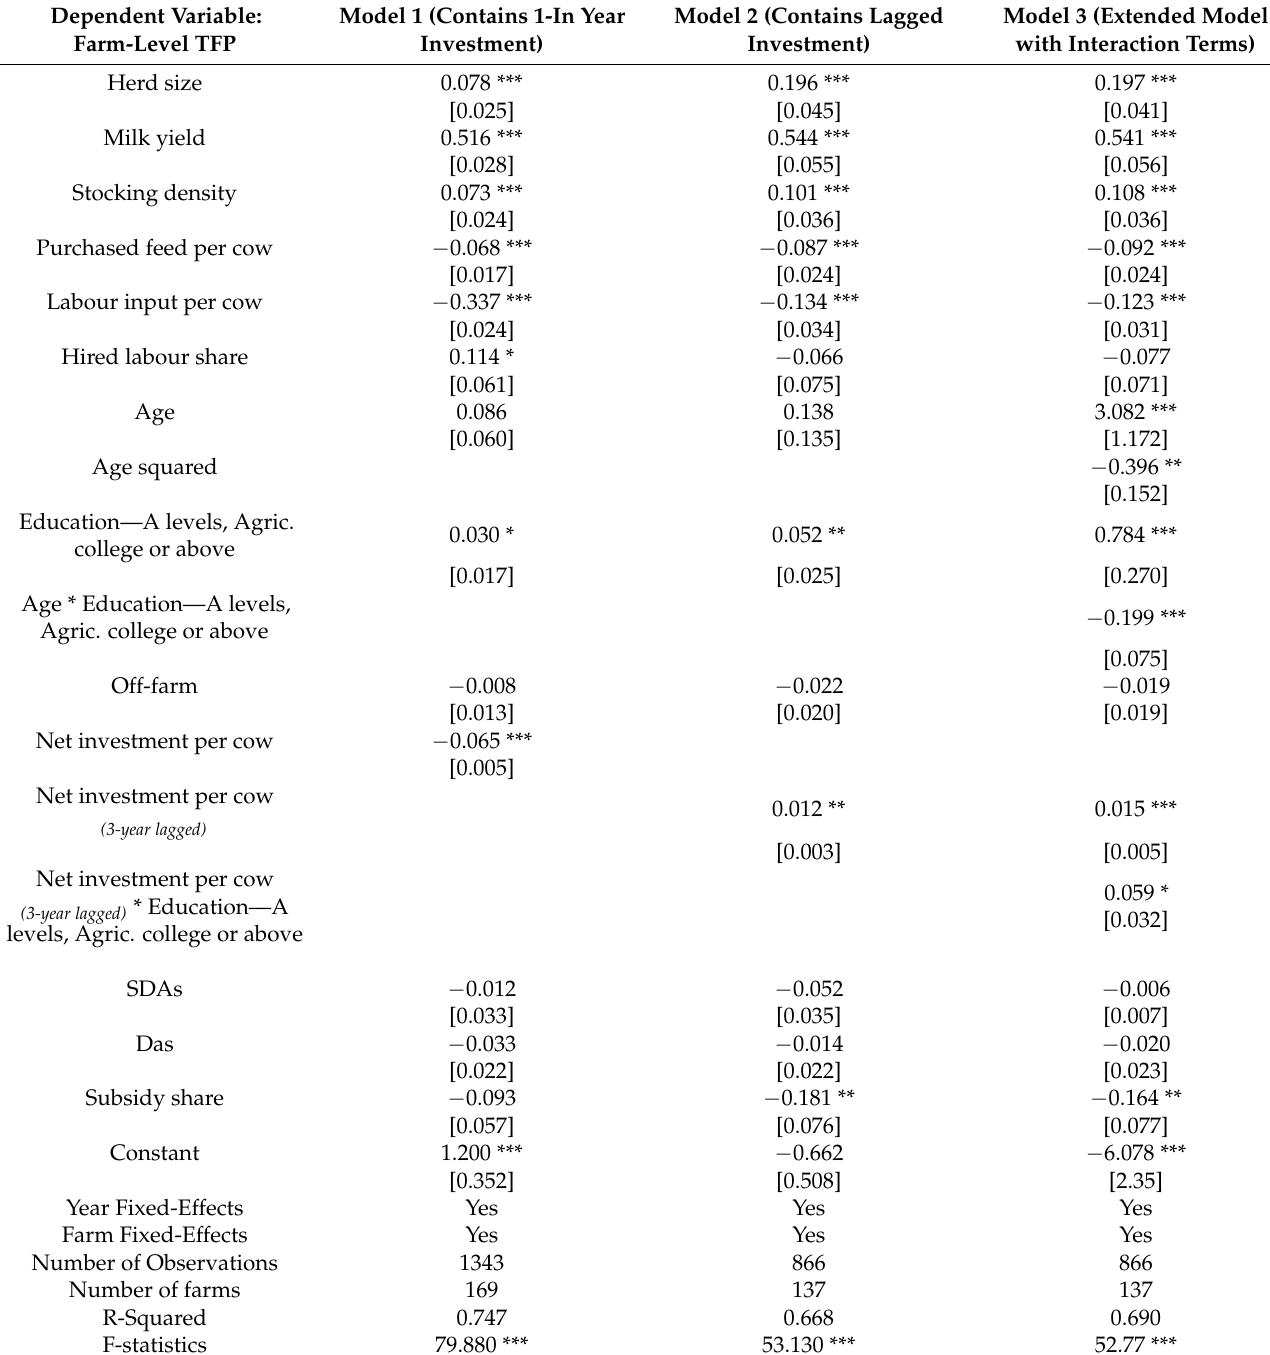
Table 3. Estimation Results of the Factors Influencing Farm TFP